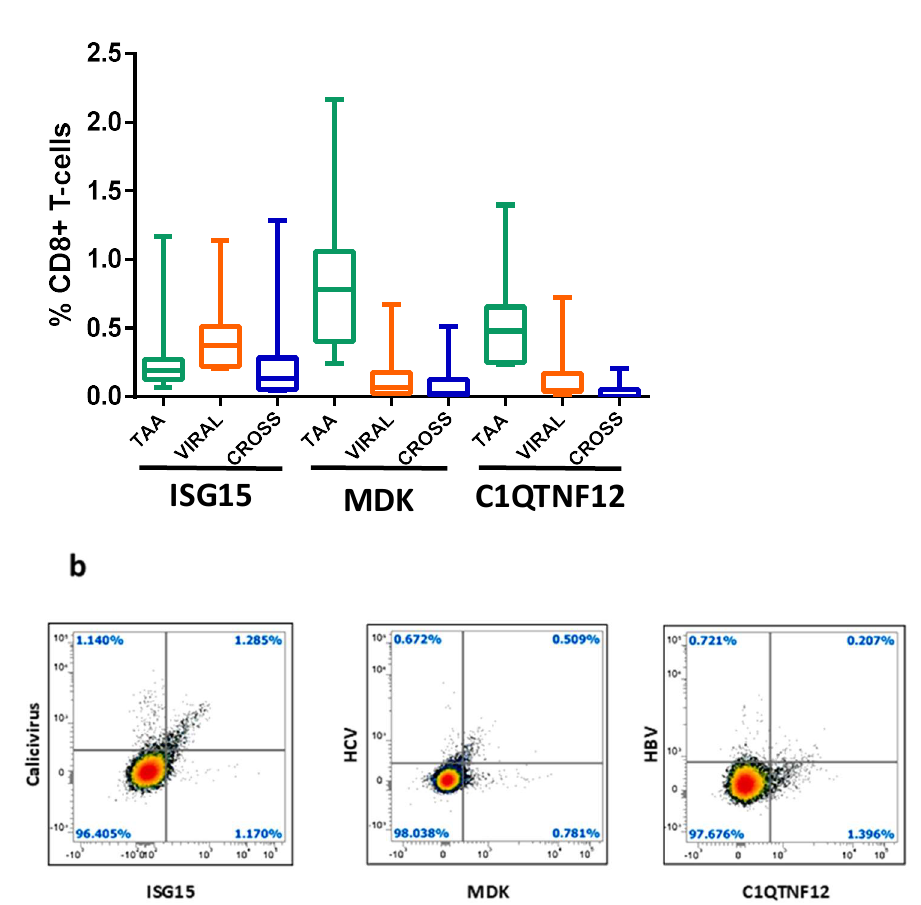
Figure 7. Evaluation of epitope-specific CD8 + T-cell clones recognizing TAA epitope, VIRAL paired epitope, and both peptides (CROSS): ( a ) cumulative data from HCC and healthy donors are shown. ( b ) pMHC-directed expansion of T cells validated the presence of T cells specific for each paired TAA and viral epitopes in a single subject. Frequencies of pMHC multimer-specific T cells out of total CD3 + CD8 + are displayed.